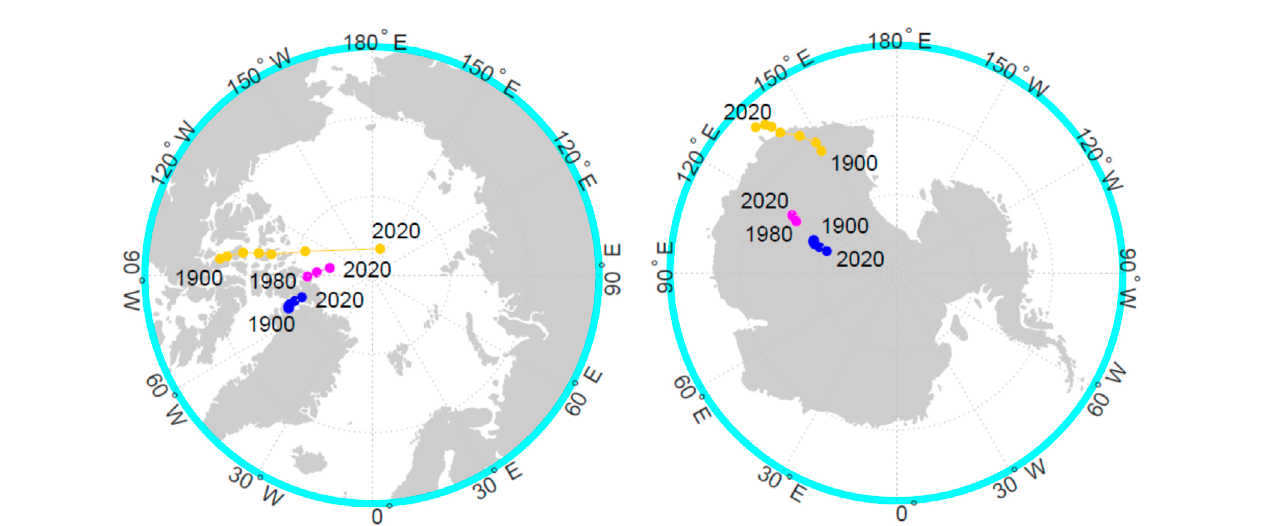
FIGURE 1 Maps of the magnetic pole locations in the (left) Northern and (right) Southern hemispheres at dates 20 years apart. The orange and blue points are dip and geocentric dipole pole locations from the International Geomagnetic Reference Field (IGRF, 12th. generation) (Thébault et al., 2015). Points are shown for 1900 to 2020 in steps of 20 years. The mauve points are the axial poles for the years 1980, 2000, and 2020 from the eccentric dipole model fits (in which the dipole axis is not constrained to pass through the centre of the Earth) of Koochak and Fraser-Smith (2017).